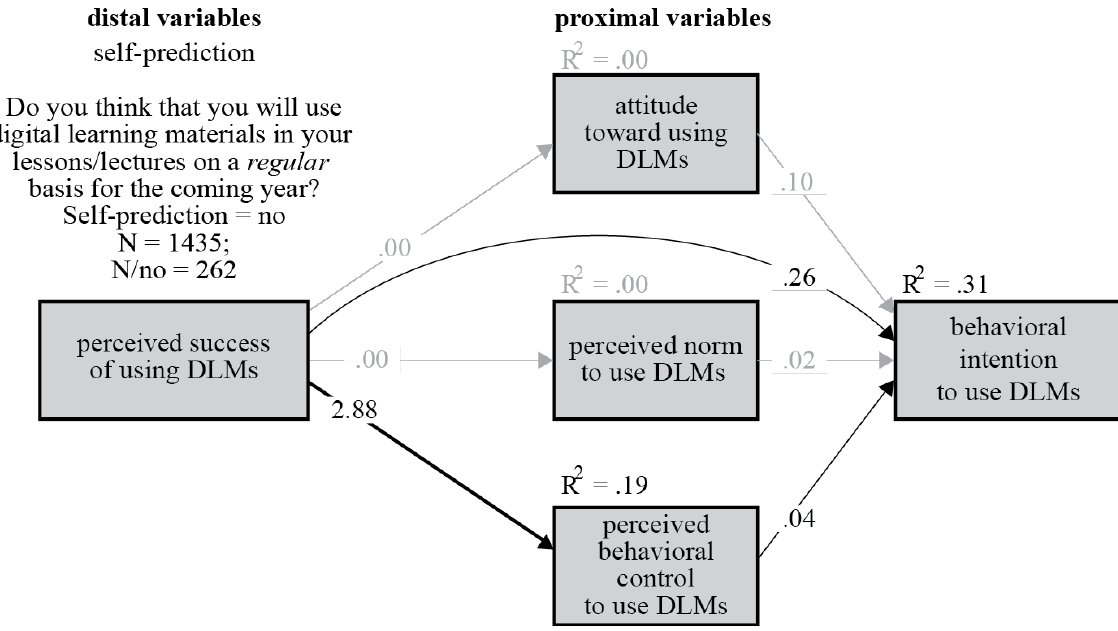
Figure 3b. Results of the mediation analysis of the model for the case that self-prediction = “no”). The displayed (unstandardized) path coefficients are significant at p <.001 level. Non-significant paths are shown grey in the figure. Thick black lines reflect the indirect effect of the distal variable via the three mediators.